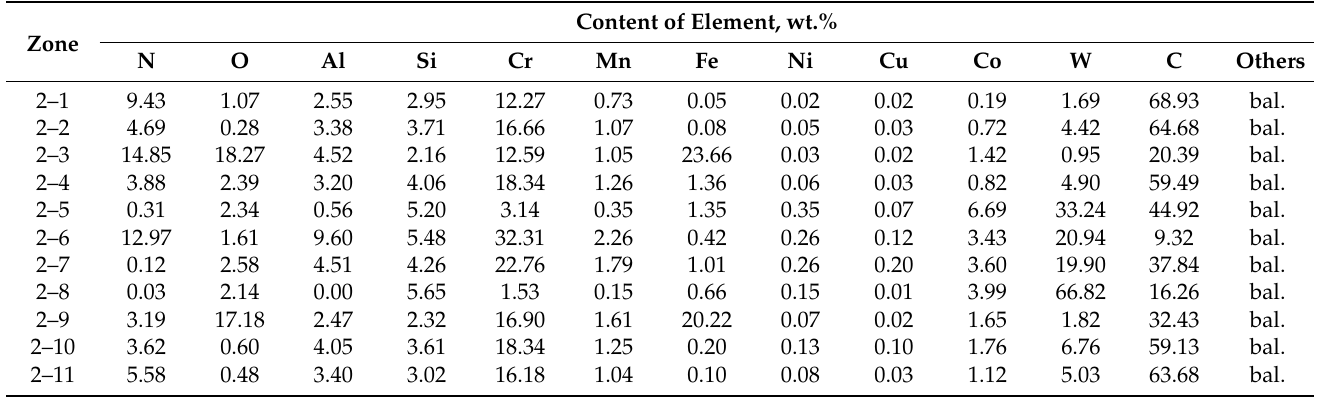
Table 3. Elemental composition of different zones of the sample surface in area 2 (edge of the friction track, band of wear particles, DLC outside the friction